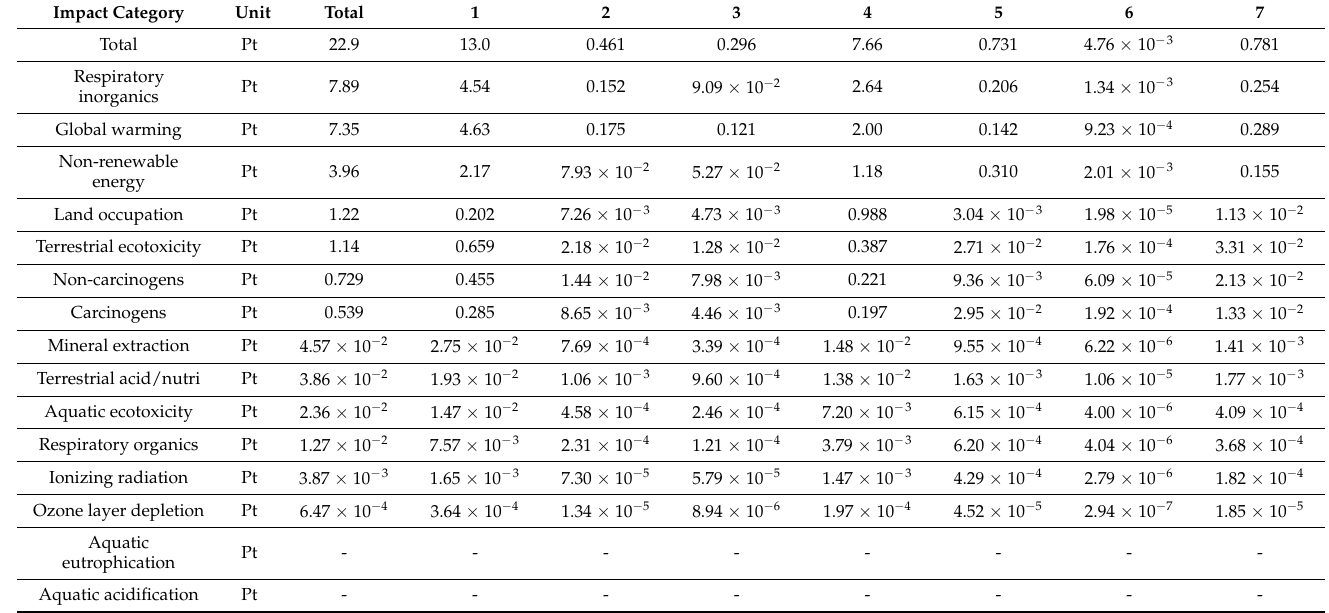
Table 2. WCB environmental damage (Pt), midpoint categories, SimaPro, IMPACT 2002+: 1. Abut- ments and piers, 2. Capping beam, 3. Abutment wall, 4. Main construction and bridge deck, 5. Bridge bearing, 6. Bridge top, 7. Bridge equipment.